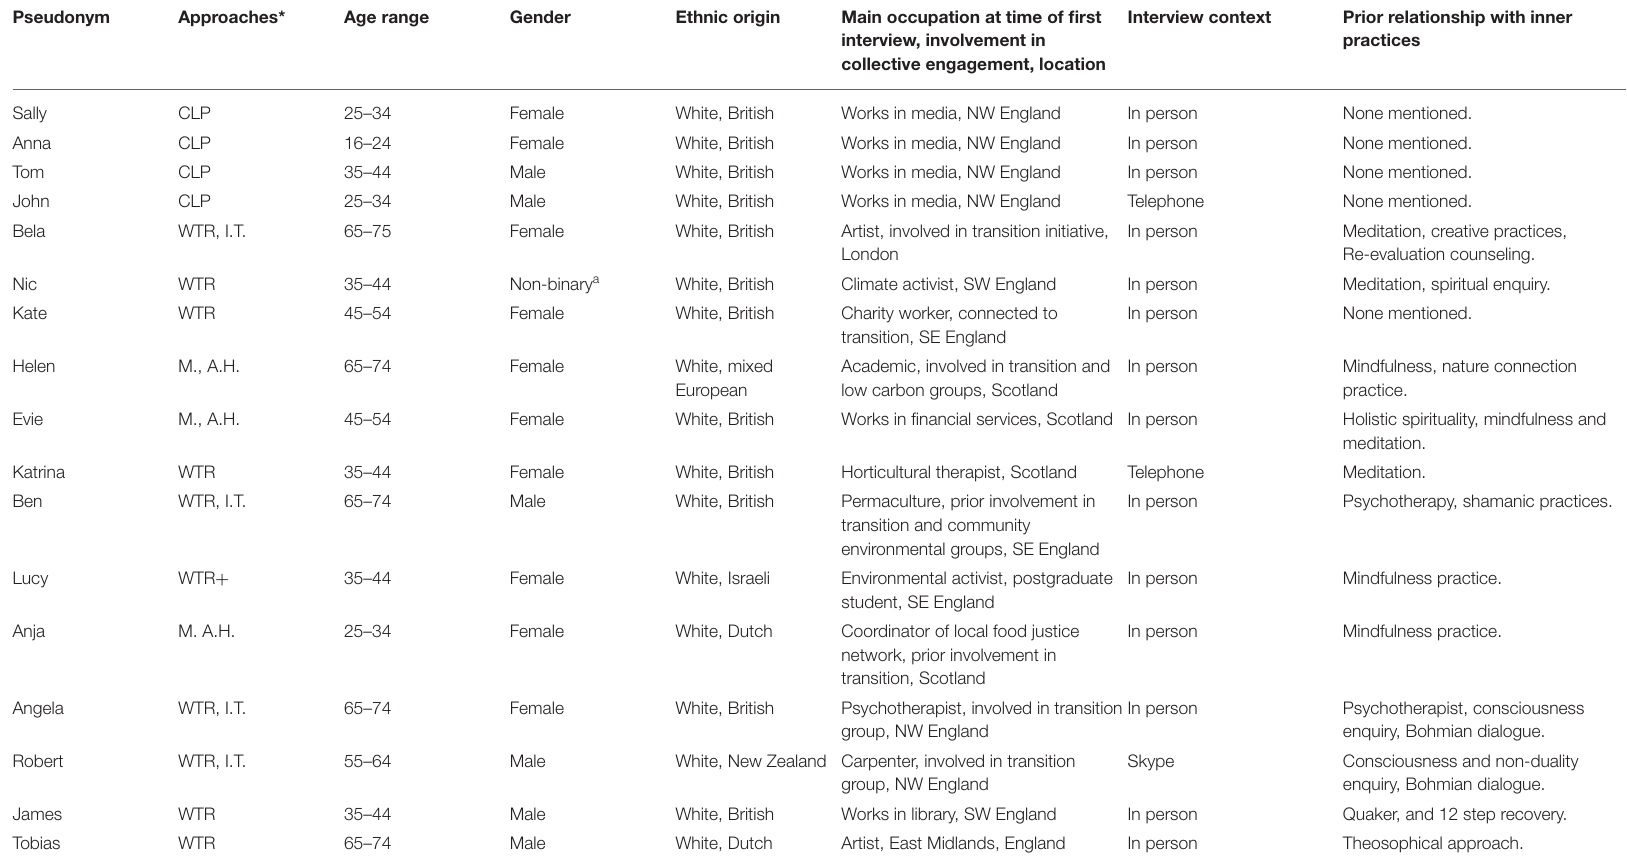
TABLE 1 | Biographical details of participant